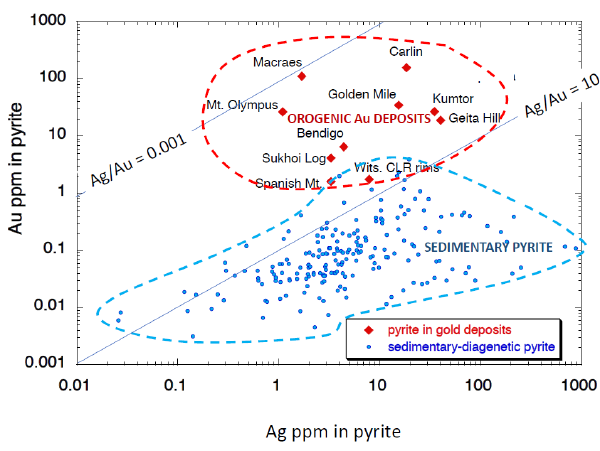
Figure 13. Ag-Au plot showing mean pyrite values for ore deposits compared with data from sedimentary pyrite [28]. The line Ag/Au = 10 roughly divides the two fields. Table 2. Mean values of As, Te, Au and Ag in pyrite from the deposits discussed in this study.